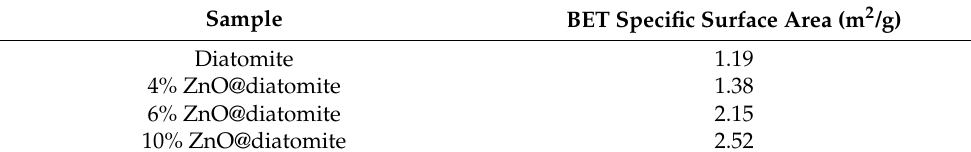
Table 2. Surface and structural characterization of the catalysts.